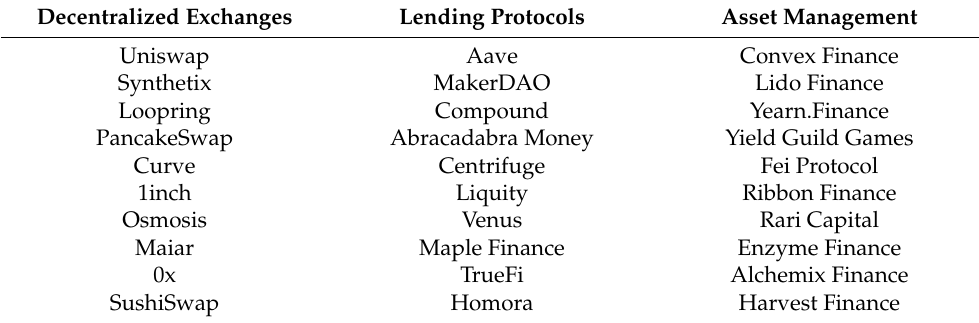
Table 1. DeFi protocols used in this study.